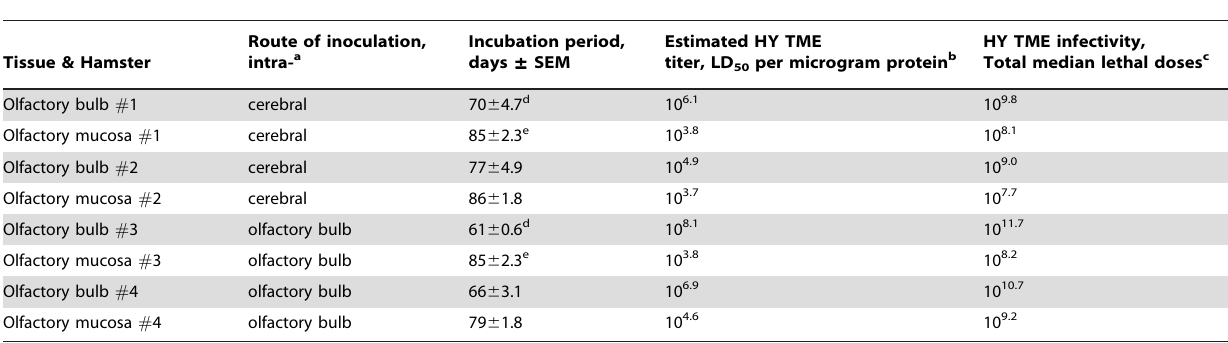
Table 2. Prion infectivity of olfactory bulb and olfactory mucosa lysates following HY TME